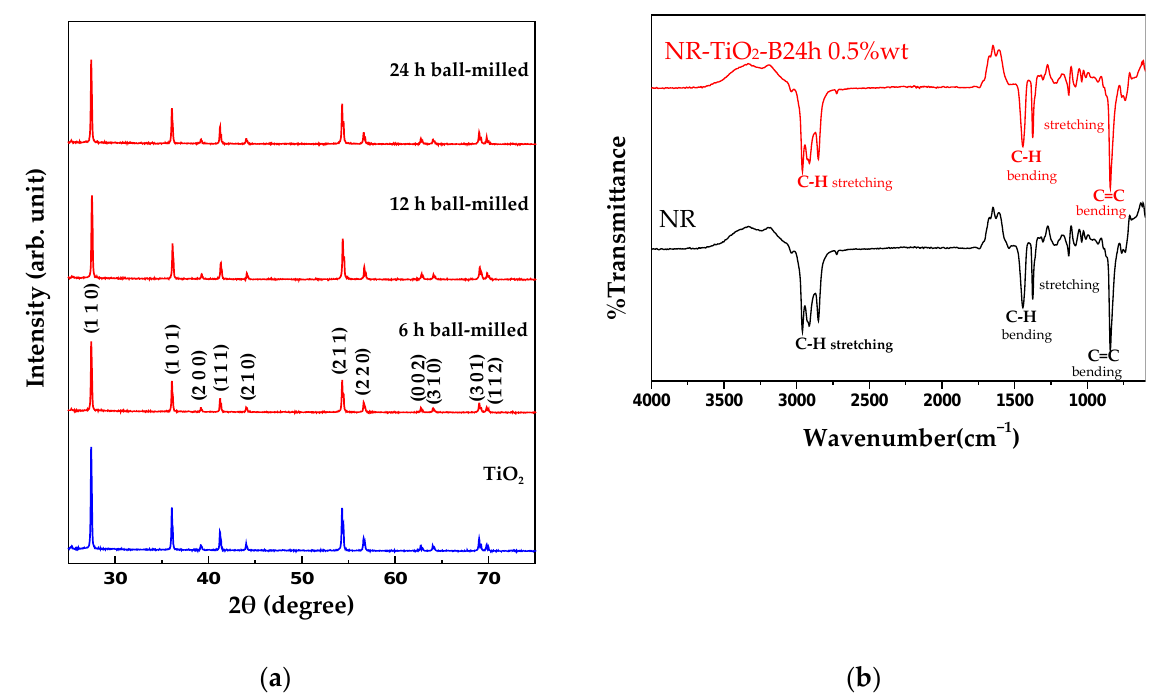
Figure 7. ( a ) XRD spectra of as-received TiO 2 and ball-milled TiO 2 at 6, 12, and 24 h. ( b ) FTIR spectra of the NR film and NR-TiO 2 -B24h 0.5%wt composite film.